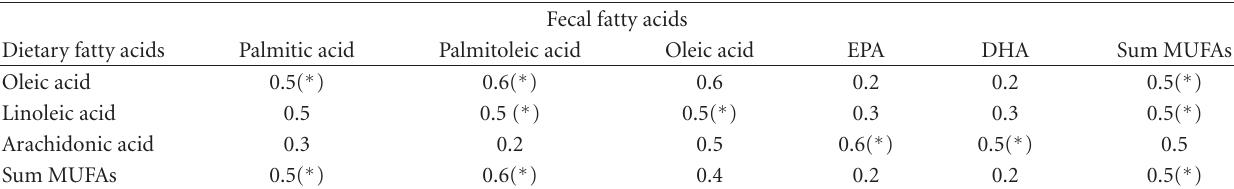
Table 2: Spearman correlation coe ffi cients ( r ) between fatty acid composition of feces and dietary fatty acids in colectomized familial adenomatous polyposis patients operated with ileal-pouch-anal anastomosis .